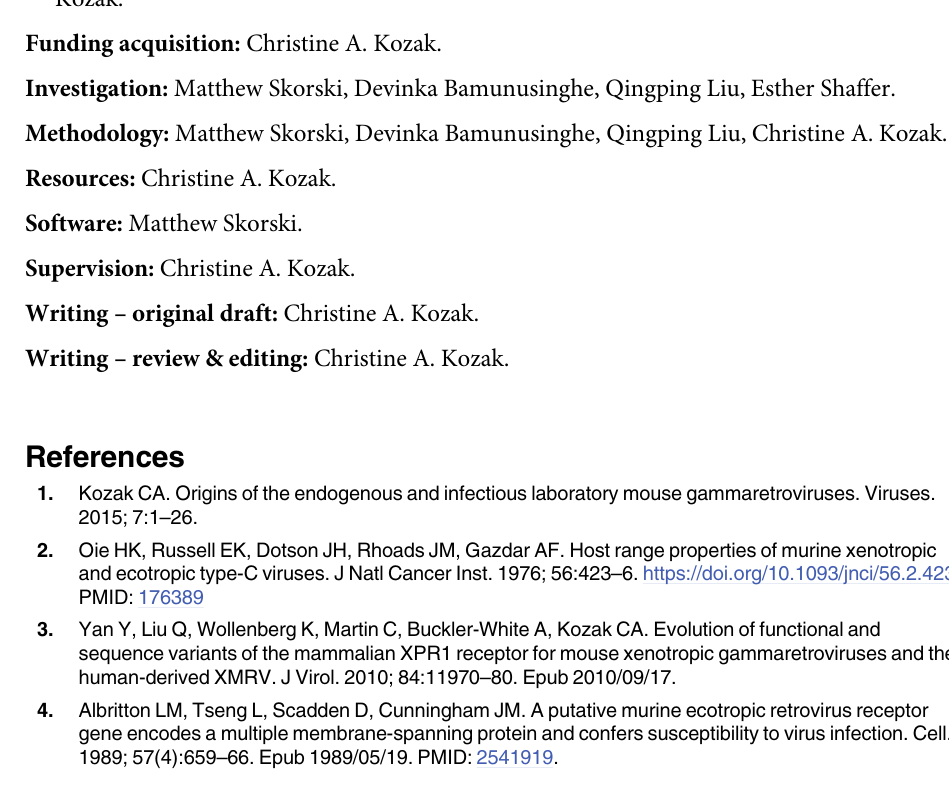
S2 Fig. Proviral sequences of known Emvs and Bxv1 orthologs in 9 inbred strain assem- blies. At the top is a diagram of the MLV proviral genome identifying locations of the LTRs with U3-R-U5 structures and gag , pol and env genes. Proviruses are identified on the right; Emv1 and Bxv1 are each present in multiple strains. Thick lines are viral sequences. Dotted lines are sequencing gaps. Red lines mark duplications. An inserted sequence is in green. Blue lines are misplaced segments with assembly positions shown by arrows. Brown lines are unplaced sequences. S1 Table. Emvs and Bxv1 orthologs in assembled genomes of inbred mouse strains. Listed ERVs are constitutively expressed or inducible and are found in eight of the 11 genomes [88– 98]. Three assembled genomes (129, FVB, NZO) have no full-length MLV ERVs capable of producing virus. Emv1-3 have small defects correctable by mutation or